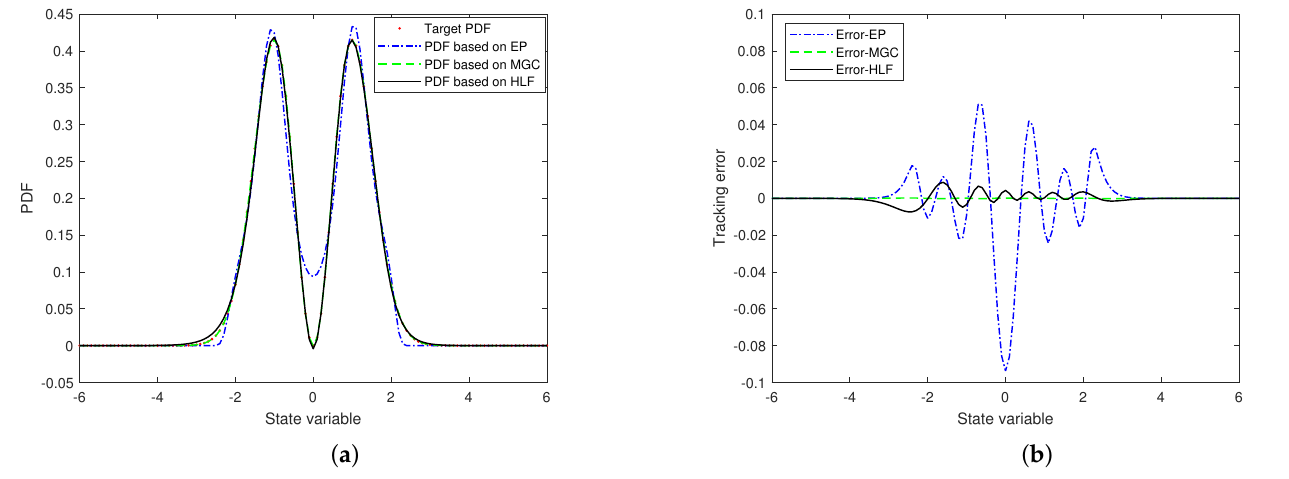
Figure 3. Case 3: Bimodal target PDF. ( a ) Control effect. ( b ) Tracking error. (4) Case